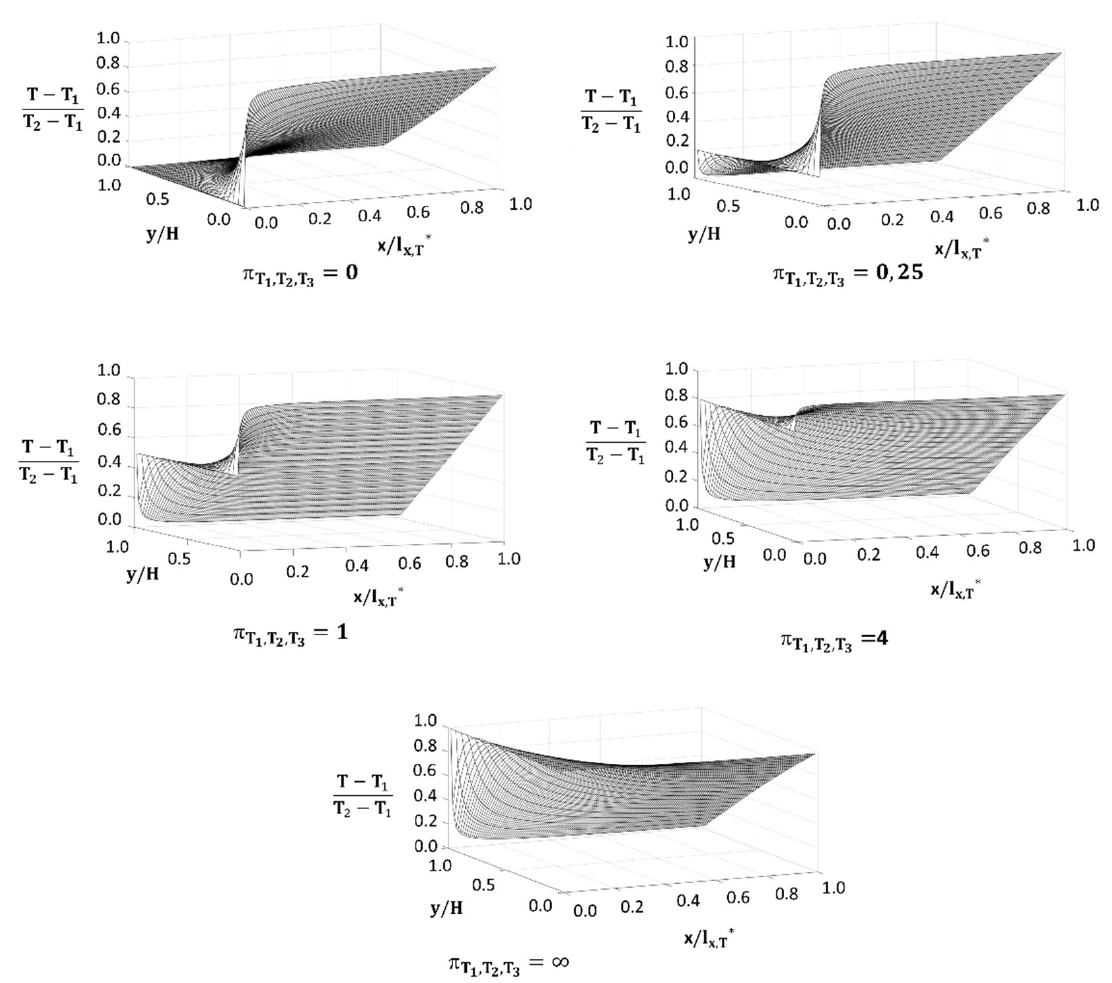
= 0,  = = 0, π = (cid:2904) (cid:3117) ,(cid:2904) (cid:3118) ,(cid:2904) (cid:3119) (cid:3117) ,(cid:2904) (cid:3118) ,(cid:2904) (cid:3119) T 1 , T 2 ,T 3 1 , T 2 ,T 3